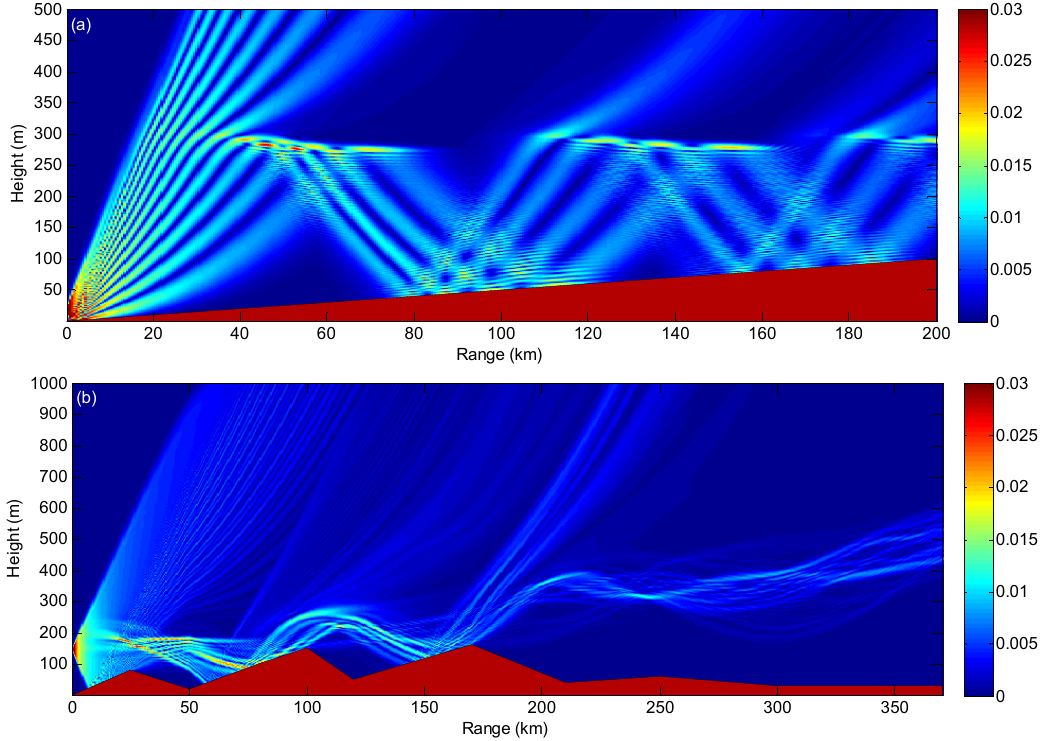
Figure 7. The coverage diagrams of the field strength computed by TPEM, ( a ) for a range-independent 300 m surface-based duct environment; and ( b ) for a range-dependent refractive environment measured between Pt. Loma and Guadalupe Island on 12 March 1948.